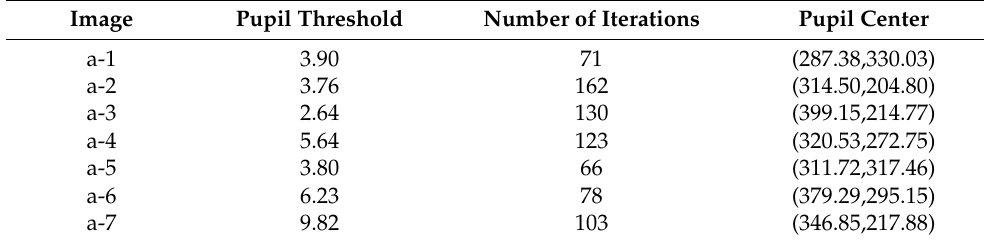
Figure 9. Dataset I image pupil segmentation detection process. ( a-1 )–( a-7 ) are the original eye images of seven different participants; ( b-1 )–( b-7 ) are the eye images after filtration by fusing the image gray intensity information and spatial location information; ( c-1 )–( c-7 ) are the eye images after fuzzy clustering segmentation; ( d-1 )–( d-7 ) are the extracted pupil binarization images; ( e-1 )–( e-7 ) are the detected pupil center locations, and the red cross “×” is the pupil center. Table 2. Pupil segmentation detection results.